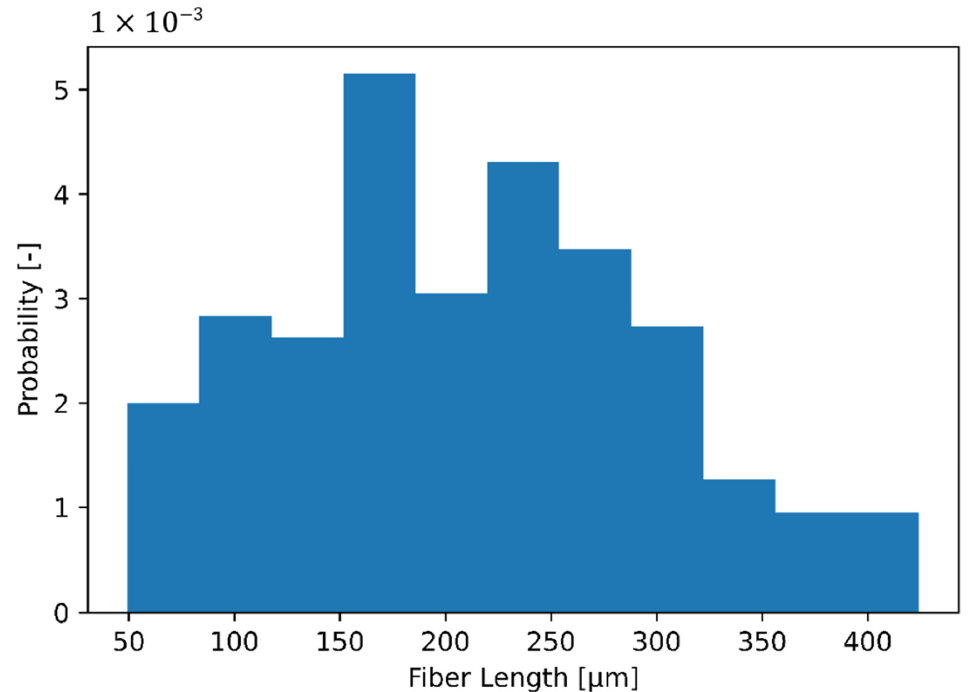
Figure 7. Normalized histogram of experimentally measured fiber lengths. Mean aspect ratio of fiber length distribution is 15.4.